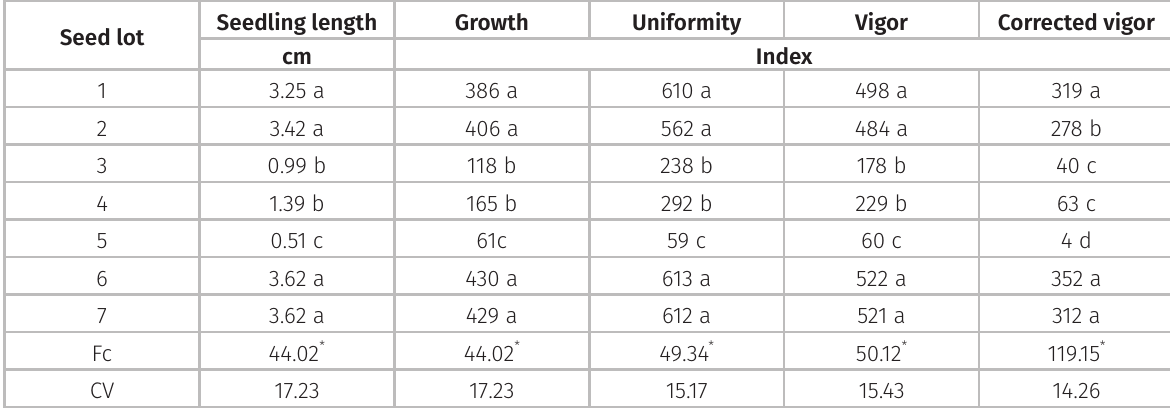
Table III. Mean values obtained for length and growth and vigor indices through analysis of seedling images coming from seven lots of Brachiaria ruziziensis